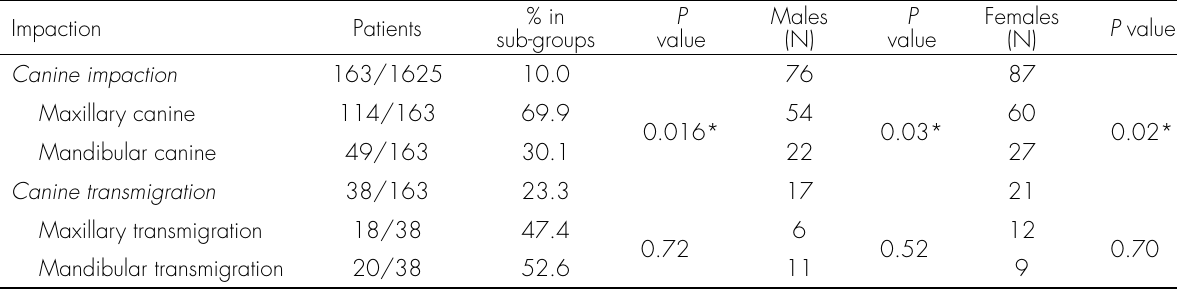
Table II. Distribution of canine impaction in the study group according to location and gender.